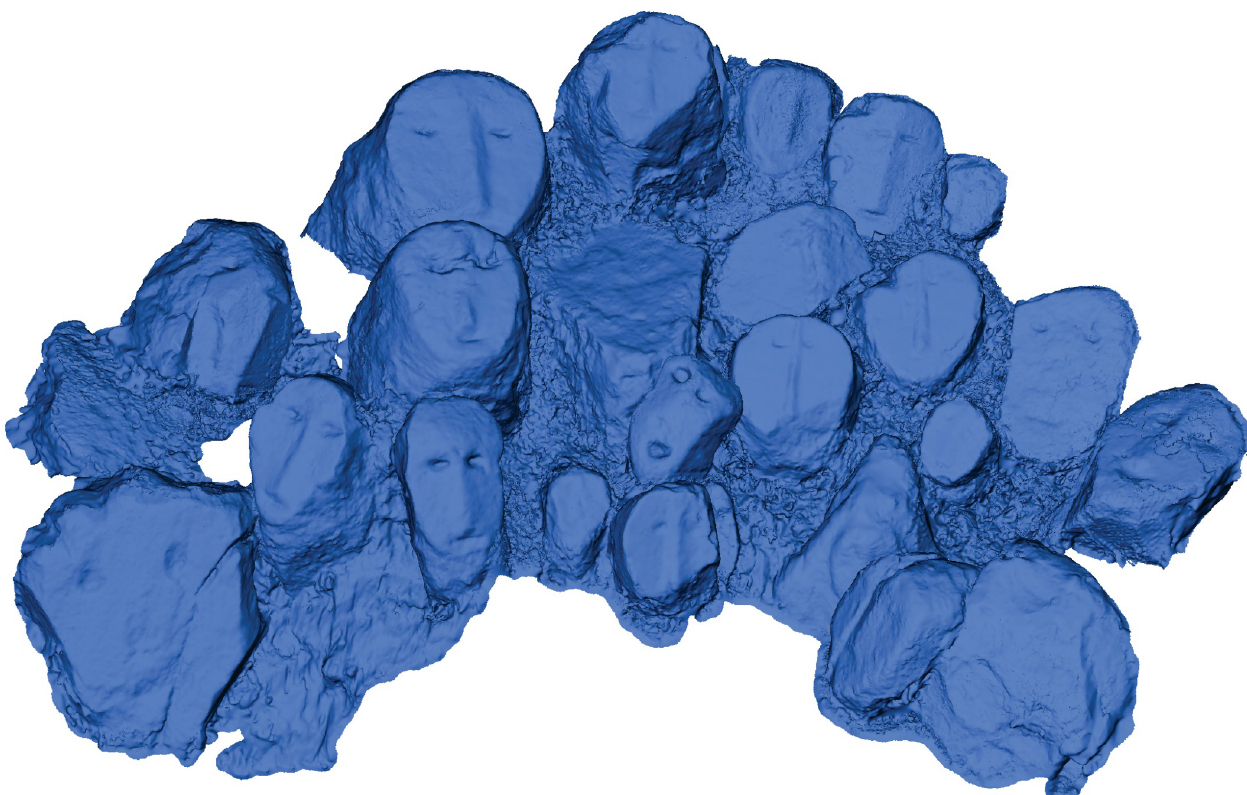
Fig 15. Model of the carved head stones at the footpaths in the Chakhesang Naga village of Zhavame (model: S. Jagiolla, graphics department of the Institute of Pre- and Protohistoric Archaeology Kiel).